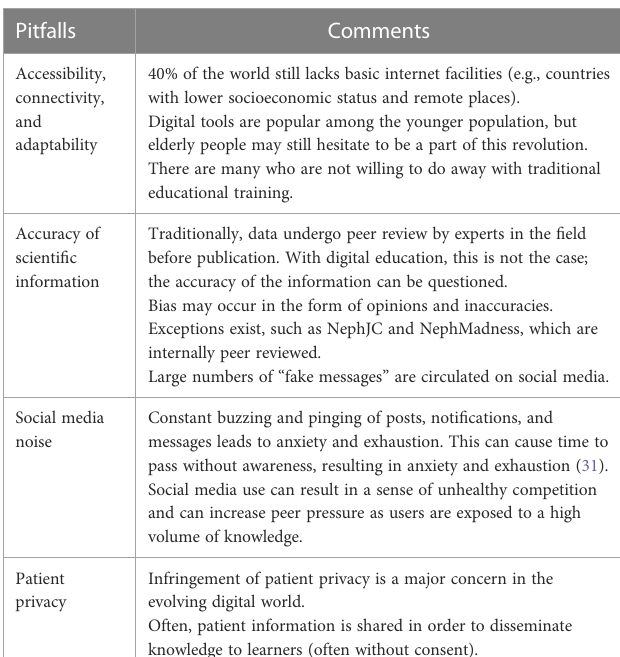
TABLE 1 Pitfalls of social media